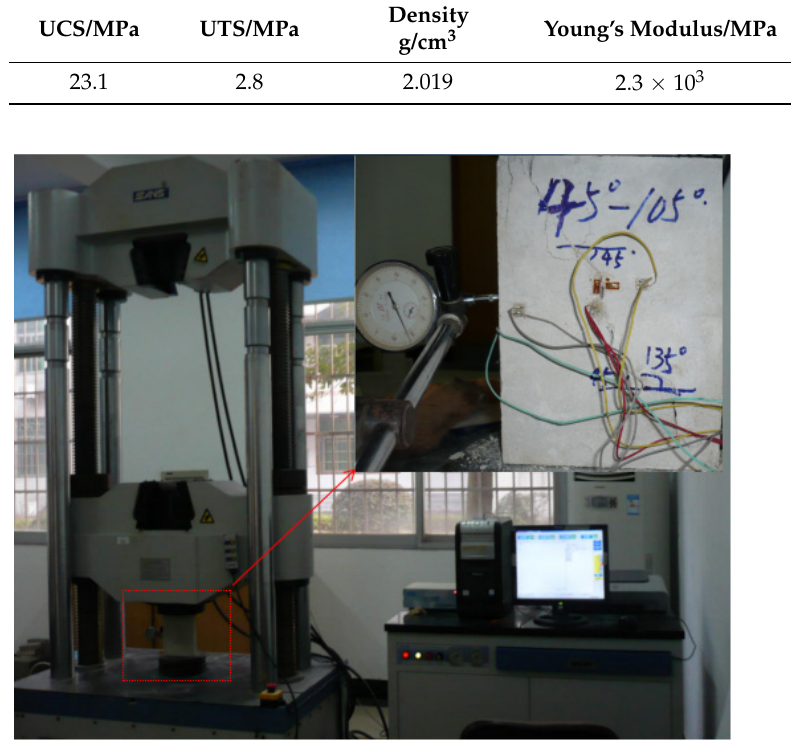
Table 2. Mechanical parameters of specimens.